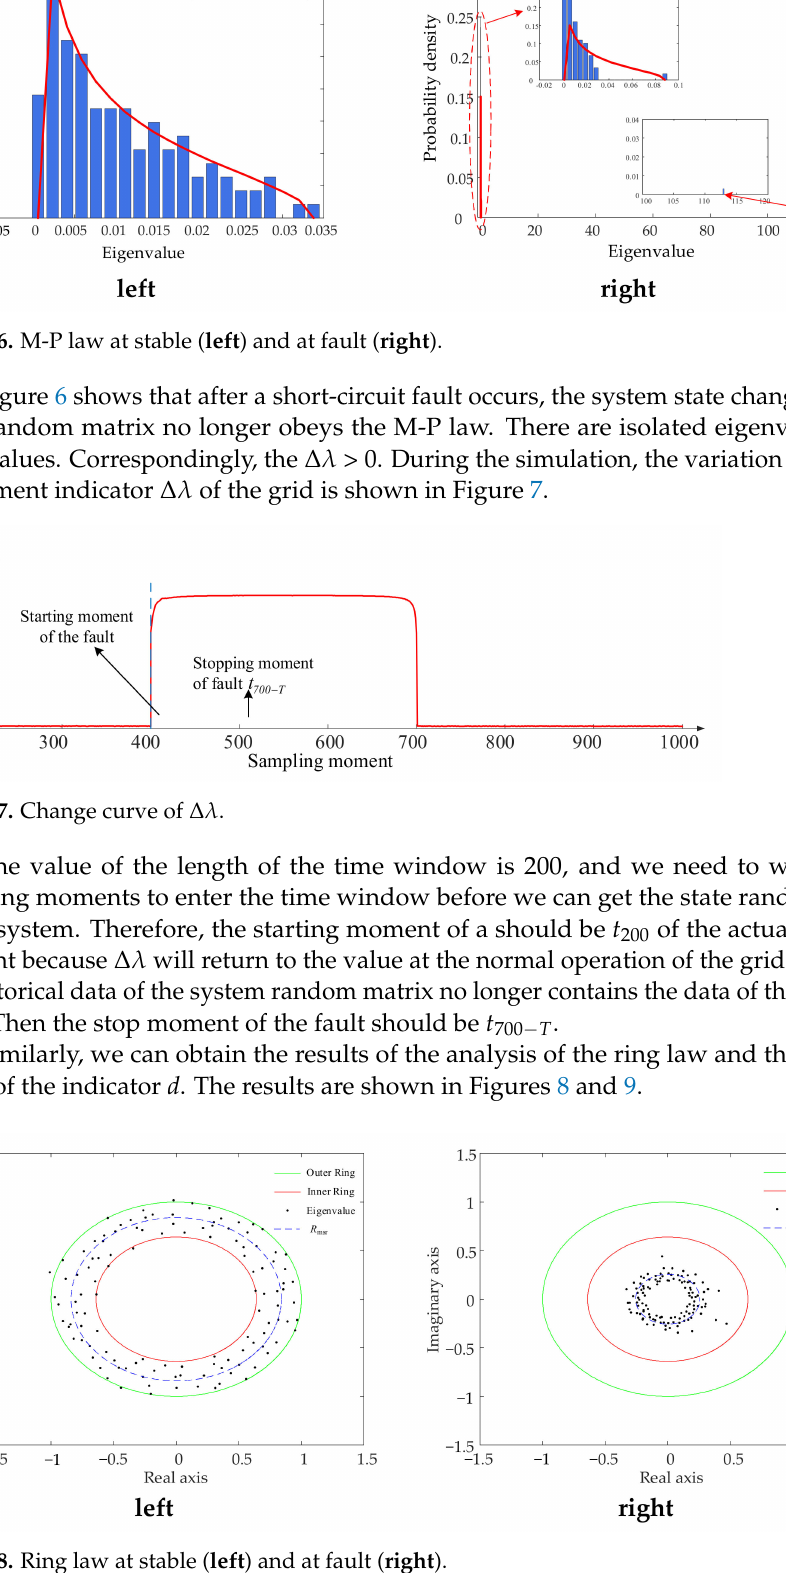
Figure 8. Ring law at stable ( left ) and at fault ( right